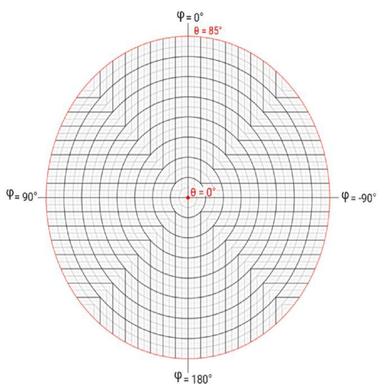
Tensor tree subdivision with theta and phi angle: the concentric circles represent θ angles and the radial lines show φ angles. The grooves of PMs are along with φ-axis 0◦–180◦.